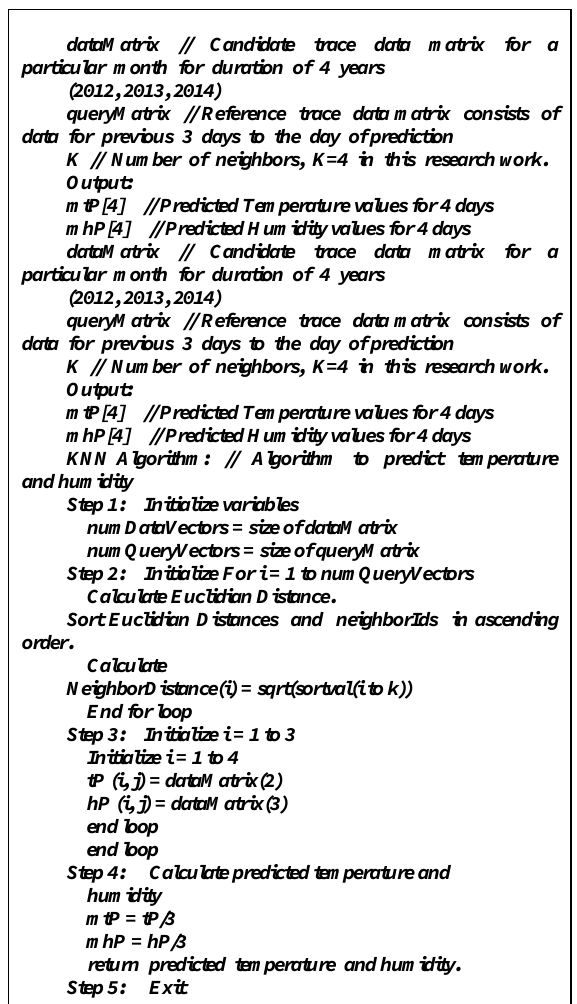
Figure 14. Database (sorted in Excel